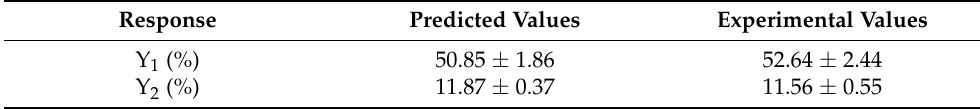
Table 3. The response of predicted and experimental values of the optimizated conditions. Response